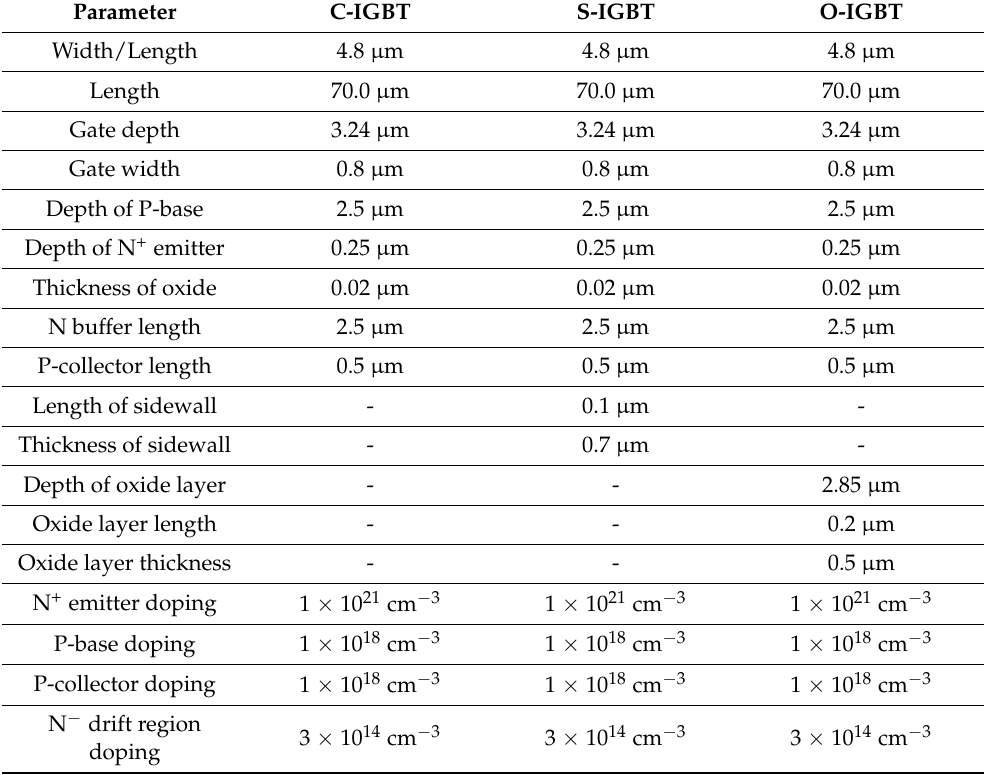
Table 1. Device parameters for